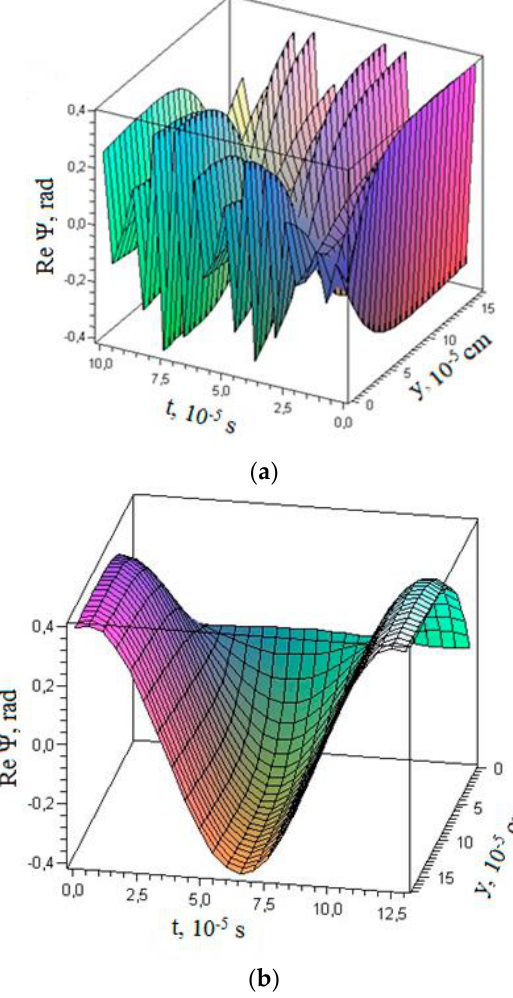
Figure 7. Graphical presentation of the solution of Equation (18), which describes the change of the angle ψ in the electric field E ( a ) and motion of the orientation bend in the FLC layer ( b ). E = 3 V/ µ m, P S = 50 nC/cm 2 , M = 4 × 10 3 erg/cm 3 , K = 5 × 10 − 12 N, γ ψ = 0.2 P, Θ 0 = 23 ◦ , and ϕ 0 = 30 ◦